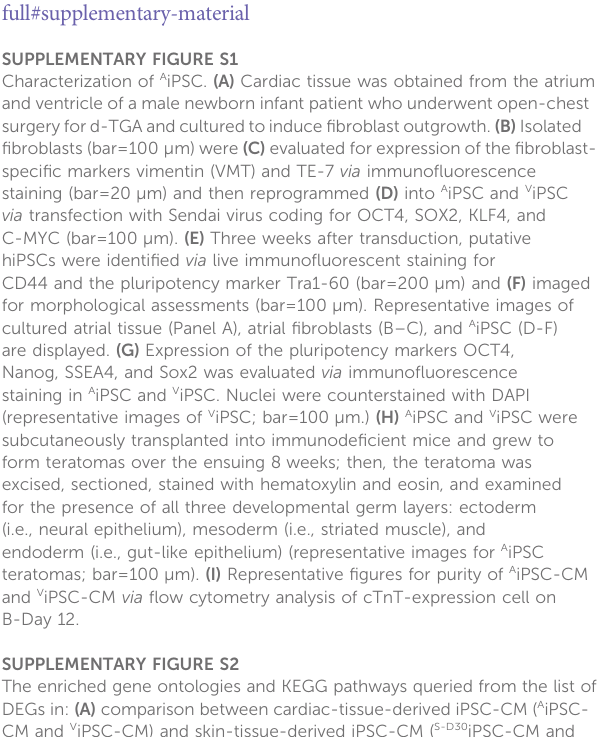
SUPPLEMENTARY FIGURE S4 No signi fi cant difference in gene expression was observed between A iPSC- CM and V iPSC-CM samples for atrial, ventricular, pacemaker cardiomyocyte marker. (A) Atrium cardiomyocyte markers, including HEY2 and MYL2, expression between A iPSC-CM and V iPSC-CM samples. (B) Ventricular cardiomyocyte markers, including MYL7 and NPPA, expression between A iPSC-CM and V iPSC-CM samples. (C) Pacemaker cardiomyocyte markers, including HCN4, TBX3, and GJC1, expression between A iPSC-CM and V iPSC- CM